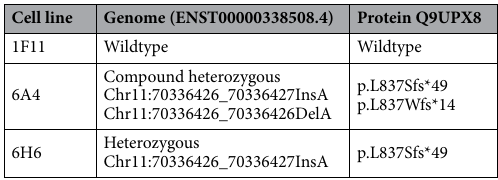
Table 1. Overview of genome-edited lines and